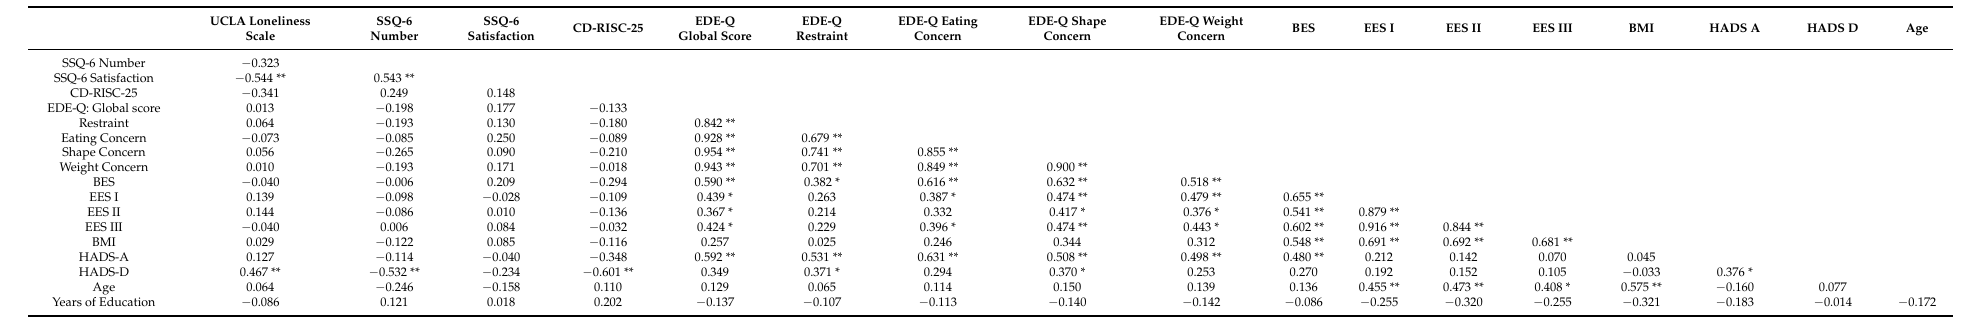
Table A2. Correlation matrix for the variables: loneliness, social support, eating disorder symptoms/features, resilience, binge eating, emotional eating, BMI, anxiety and depression levels, age, and years of education for the ED patients